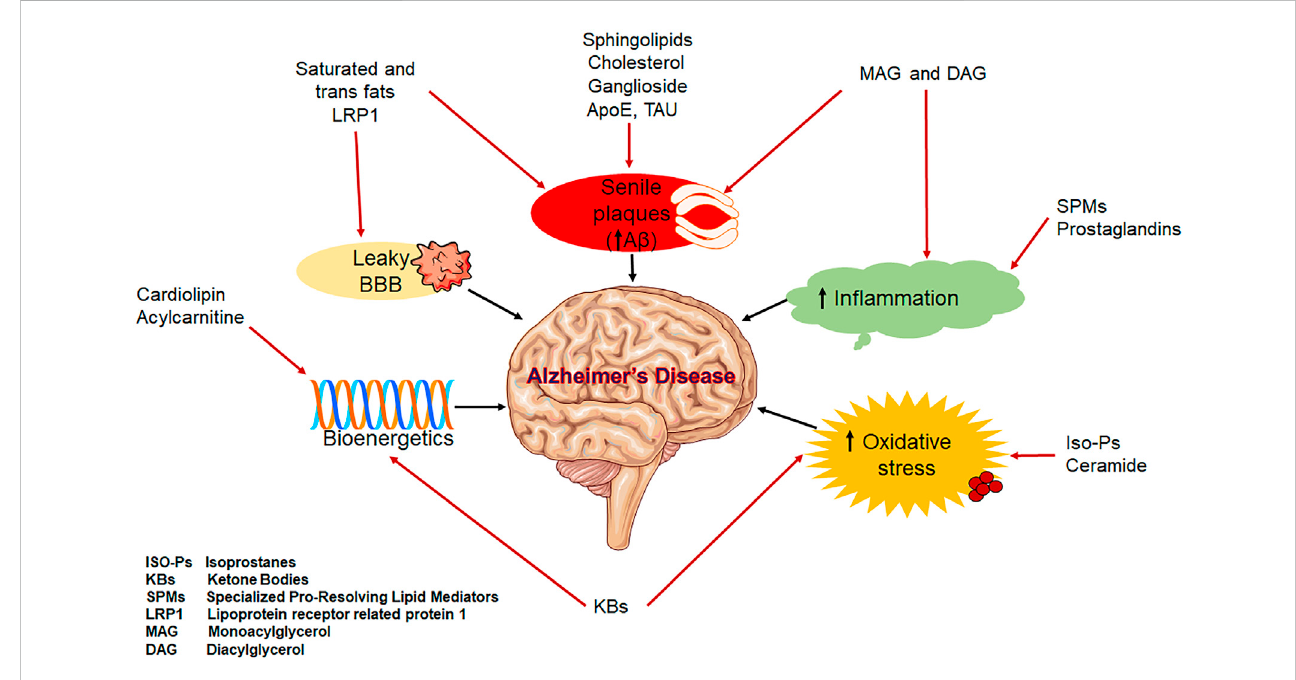
FIGURE 3 Schematic representation of lipids involved in